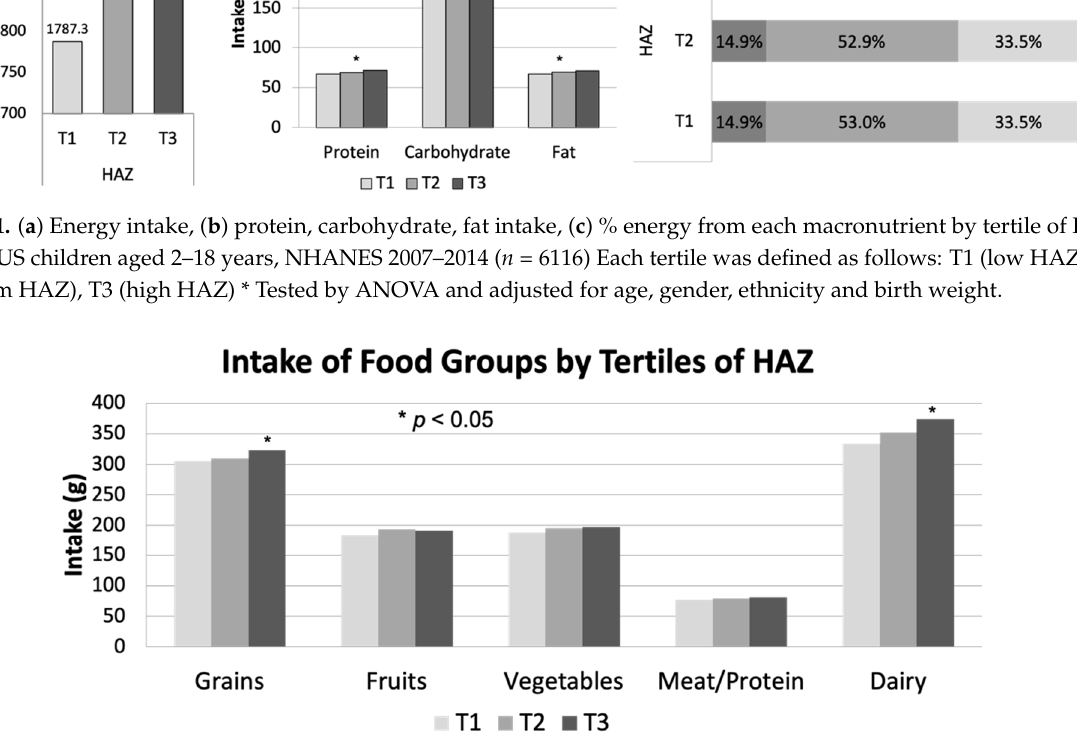
Figure 2. Intake of five food groups by tertile of HAZ among US children aged 2–18 years, NHANES 2007–2014 ( n = 6116). Each tertile was defined as follows: T1 (low HAZ), T2 (medium HAZ), T3 (high HAZ) * Tested by ANOVA and adjusted for age, gender, ethnicity and birth weight. HAZ, height-for-age Z score. Table 3. Odds ratios and 95% CIs for consuming below the EAR by tertile of HAZ among US chil- dren aged 2-18 years in NHANES 2007-2014 ( n = 6116).